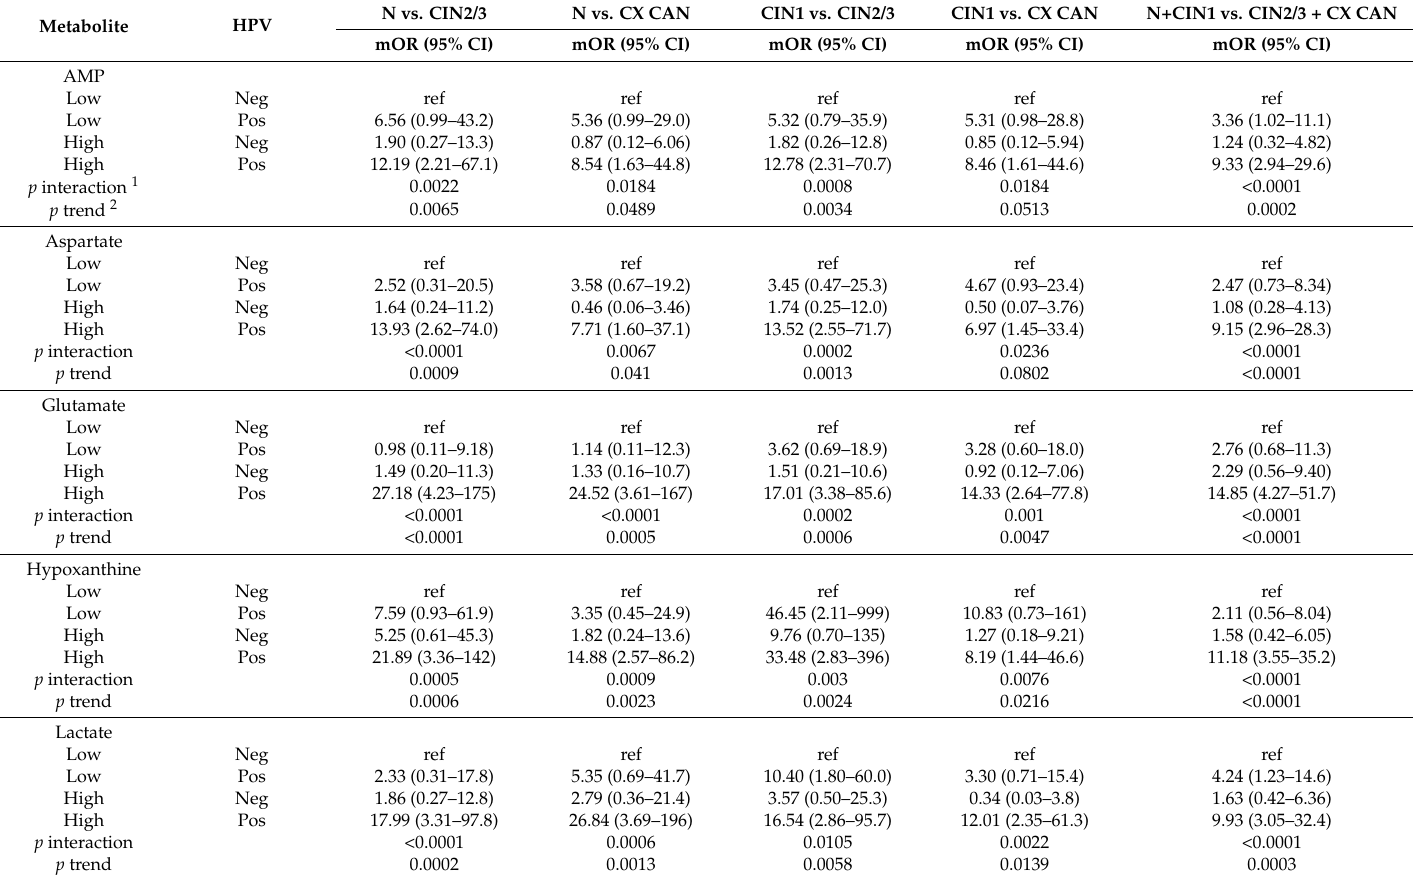
Table 4. Combined effects of metabolites with human papillomavirus (HPV) status on CIN2/3 and cervical cancer